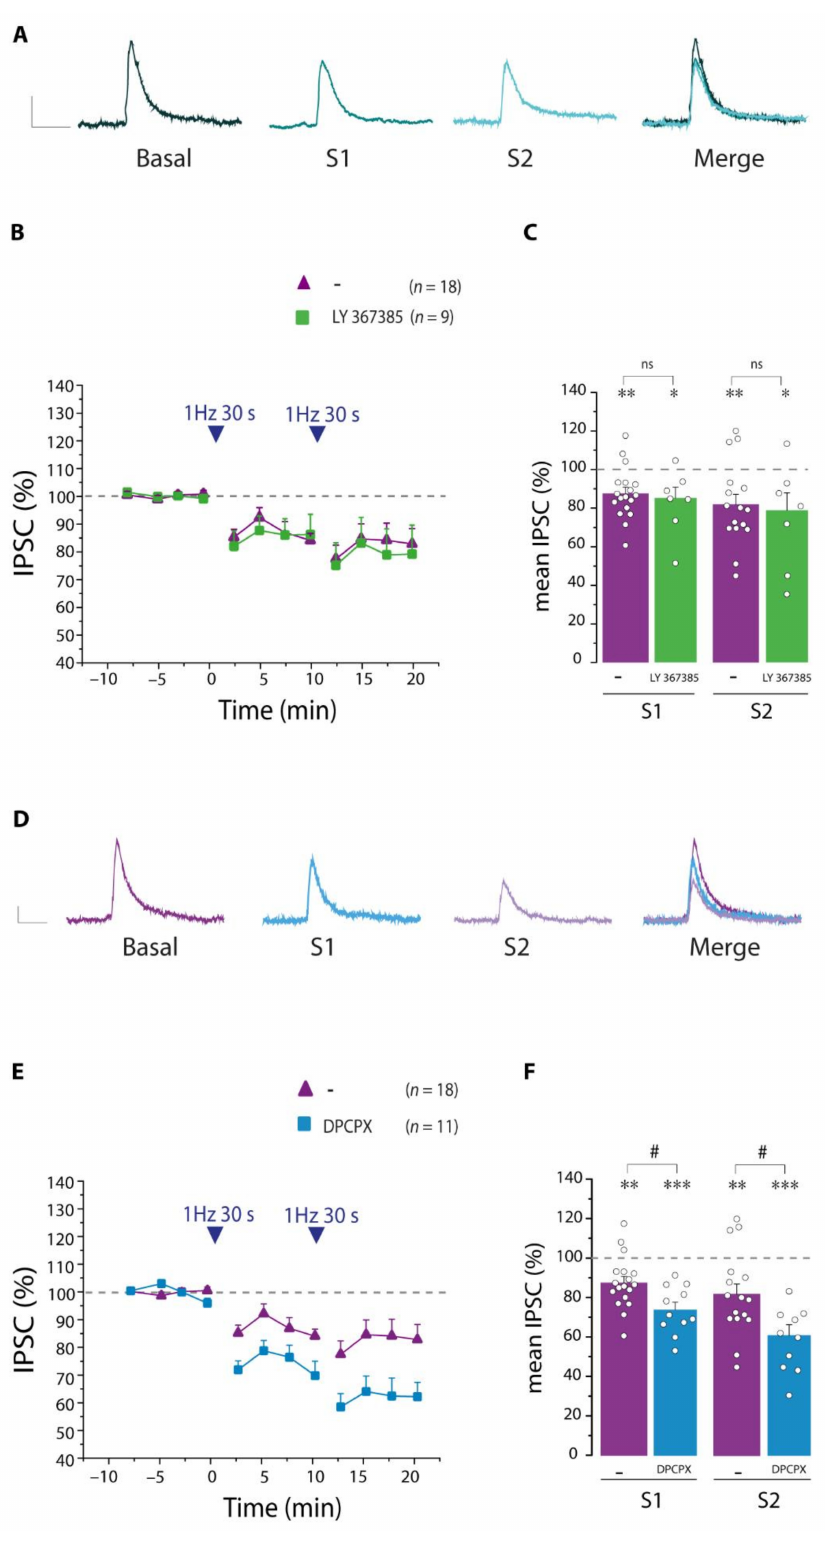
Figure 11. Activation of A 1 Rs enhances SST interneurons inhibitory transmission after intense SST interneuron stimulation. ( A ) Representative IPSC traces before (basal) and after the first (S1) and the second (S2) 30 light pulse stimulations in the presence of the mGluR1 antagonist LY 367385 and merge of all representative traces. ( B ) Normalized IPSC amplitudes before and after the 30 light pulse